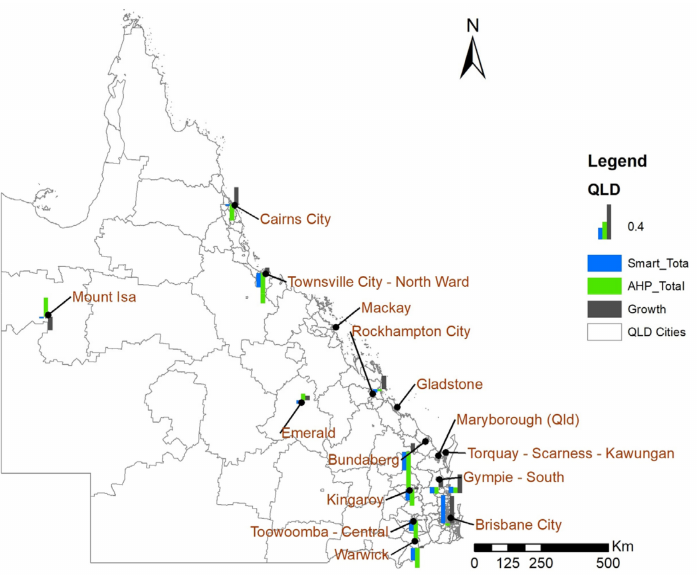
Figure 12. Smart city performance, Preference, and population growth of Queensland’s 18 cities. 10 cities of Western Australia qualified the city selection criteria. As in all states, the greater city (Perth) performed as the smartest city and observed the highest growth rate in last decade. Other than Perth and Busselton, all other cities experienced around the average population growth. Figure 13 shows the performance of Western Australian cities.